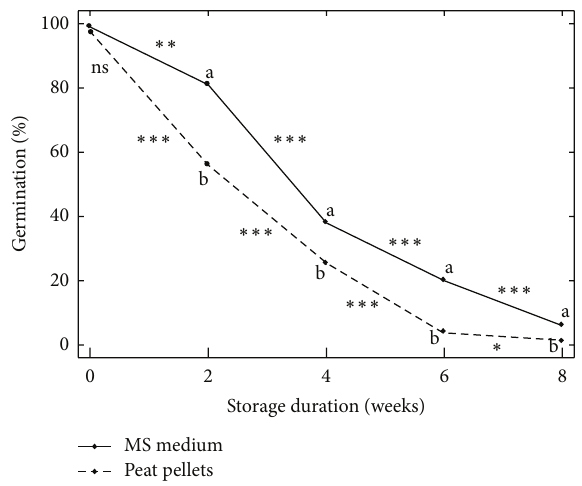
MS medium Peat pellets Figure3:Percentagesofencapsulatedmicroshoots(syntheticseeds) and nonencapsulated microshoots of two Begonia cultivars “ger- minating” (developing successfully) after storage and subsequent transfer to MS medium ( in vitro ) or peat pellets ( ex vitro ). Medium and storage duration were highly influential in significant interac- tion terms among five treatment factors; therefore, analyses were run at each combination of these two factor levels. Means shown (dots) are averages among the three additional treatment factors (cultivar, CaCl 2 ⋅ H 2 O exposure duration, and storage temperature), which showed no significant interaction effects when analyzed by medium and storage duration. Means for the two media at a specific storage duration (vertical pairs) are significantly different ( 𝑃 = 0.05 ) when labeled with “a” and “b” or not significantly different when labeled with “ns.” Means for storage durations connected by a line segment are significantly different at 𝑃 = 0.05 ( ∗ ), 0.01 ( ∗∗ ), or 0.001 ( ∗∗∗ ). The Schaffer-Simulated method was used for multiple mean